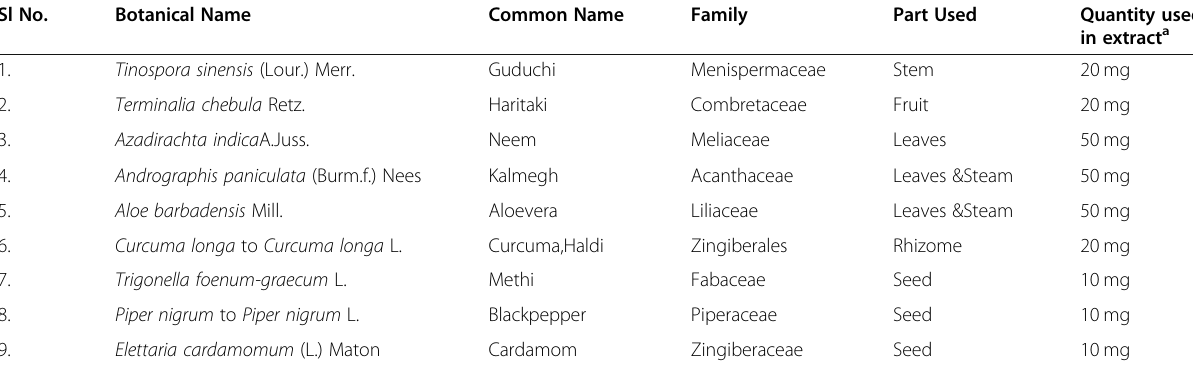
Table 2 Composition of ingredient(s) present in AKSS16-LIV01 Sl